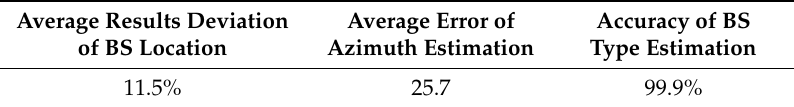
Table 5. Statistical Results of the Proposed